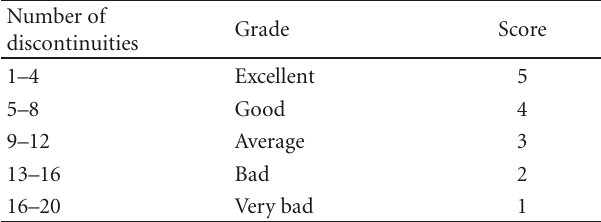
Table 3: The relationship between grade and score for the populus samples.